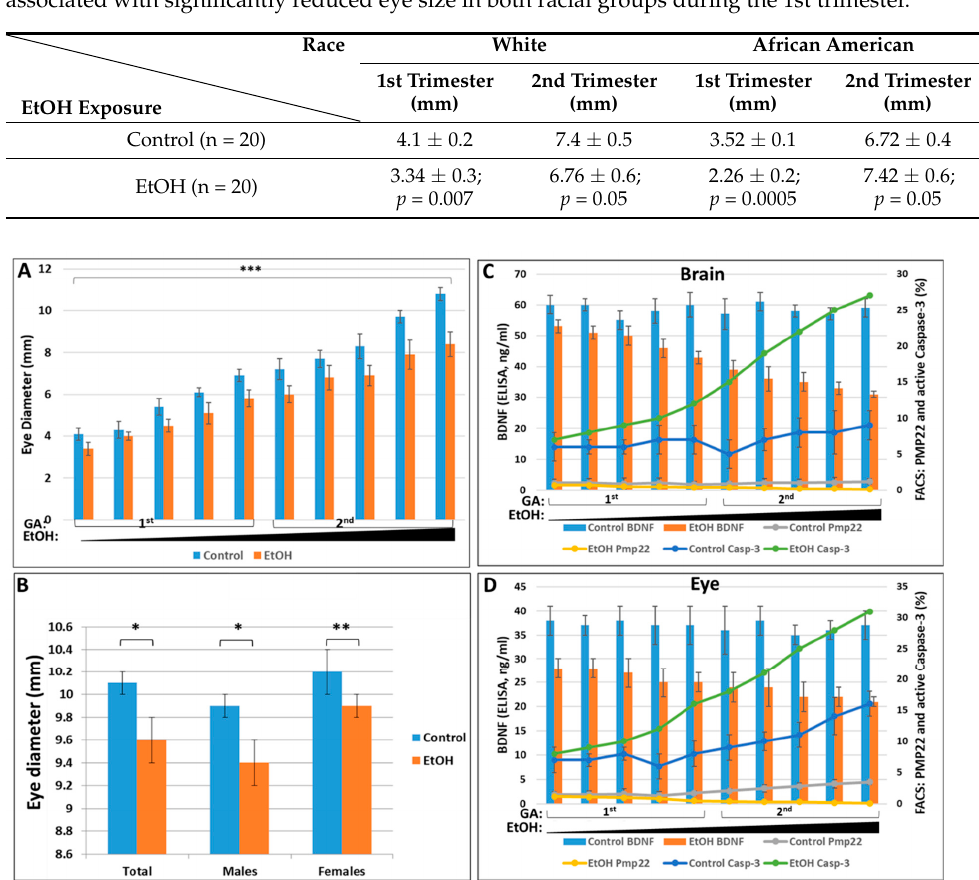
Figure 4. Influence of sex and EtOH dose on the effects of in utero exposure to alcohol on human fetal eye development during 1st and 2nd trimesters in EtOH-exposed samples compared to unexposed controls. ( A ) Direct correlation between reduction in eye diameter and total alcohol dose. Samples from 10 pairs of fetuses GA- and sex-matched with fetuses whose mothers’ last drink (if any) occurred before pregnancy, arrayed within each trimester by the estimated total EtOH exposure. The estimated alcohol dose was calculated as the product of the total drinks in a week, the alcohol dose per drink, and the number of weeks of exposure. The p -value *** refers to the mean eye diameter for all EtOH-exposed fetuses vs. the means for the GA- and sex-matched controls. ( B ) In the same 10 matched pairs of fetuses, exposure to EtOH was associated with reduced eye diameters. Fetal sex was determined by RT-PCR with SRY primers. Eye diameter was measured on histological sections. The p-values between EtOH-exposed and unexposed controls are based on the number of fetuses studied, not the number of triplicate measurements. Although the fold change associated with exposure to EtOH was slightly greater in males (0.04-fold reduction in eye diameter) than in females (0.03-fold reduction), this was not statistically significant ( p = 0.09). * p < 0.05; ** p < 0.01. Reduction in BDNF and PMP22 levels was correlated with caspase-3 activation, and with alcohol dose during 1st and 2nd trimesters in brain ( C ), and in fetal eye ( D ). Correlation between alcohol dose and expression of PMP22, BDNF and active caspase-3 in brain and eye (BDNF is presented as bars on the primary y-axis (left); PMP22 and active caspase-3 are presented as lines on the secondary y-axis (right). Total cumulative alcohol dose for 1st trimester was 57–168 (or 12–30 drinks/month), and for 2nd trimester was from 54.4 to 1827.5 (or 6–320 drinks/month). Each assay was performed in triplicate and in frames ( A , C , D ), each bar represents one fetus, and the variability of the measurement technique is indicated by standard deviations based on those three